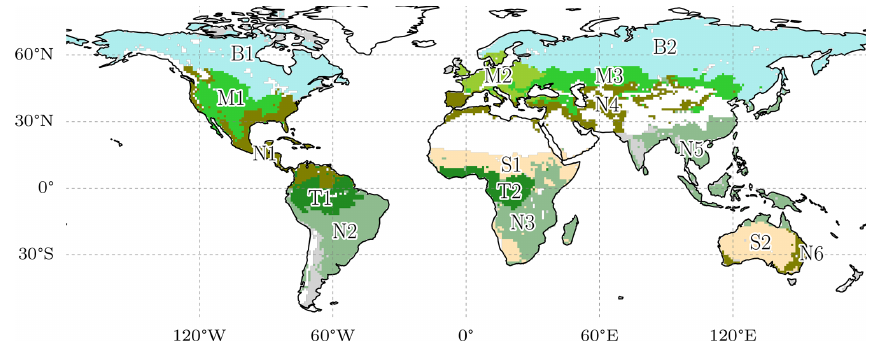
Figure 2. Continental hydro-climatic regions, adapted from Papagiannopoulou et al. (2018). Boreal – North America (B1) and Eurasia (B2); temperate – North America (M1), Europe (M2), and Asia (M3); transitional – North and Central America (N1), South America (S2), Africa (N3), Eurasia and North Africa (N4), Southeast Asia (N5), and Australia (N6); subtropical – Africa (S1) and Australia (S2); tropical – South America (T1) and Africa